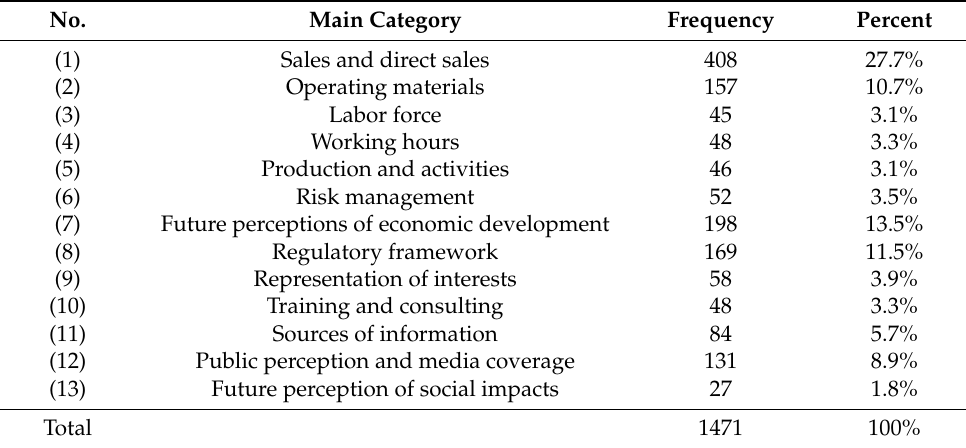
Table 1. Impacts of COVID-19 on Austrian agriculture—13 main